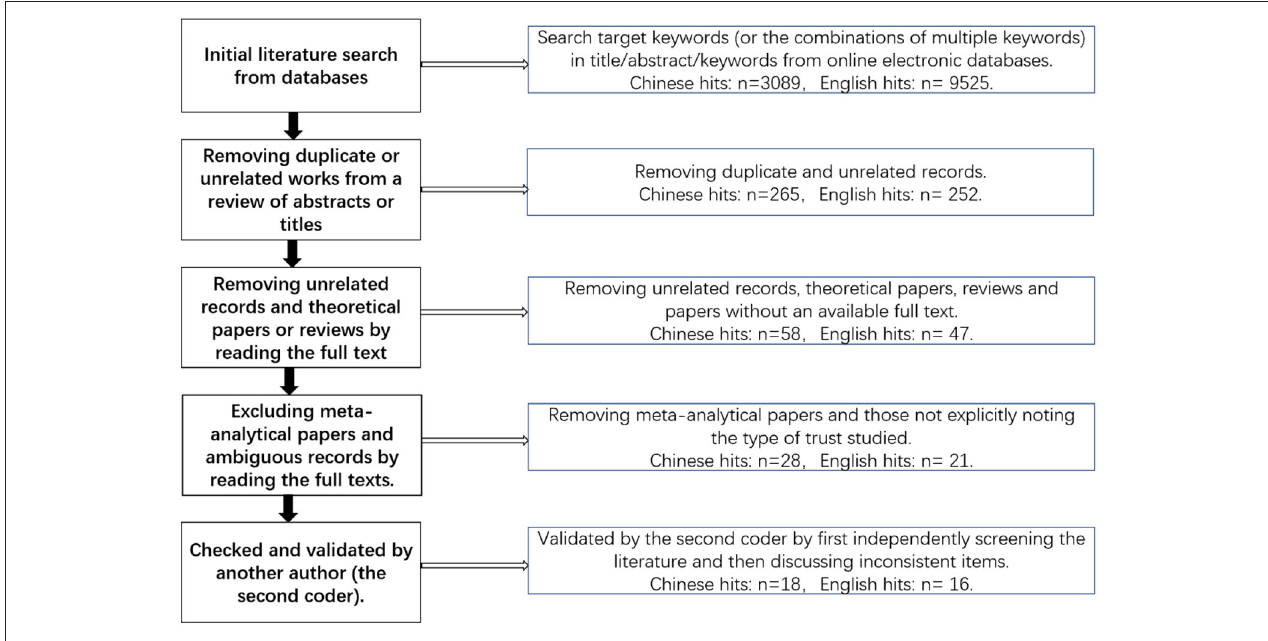
FIGURE 1 | A schematic illustration on the process of literature inclusion and